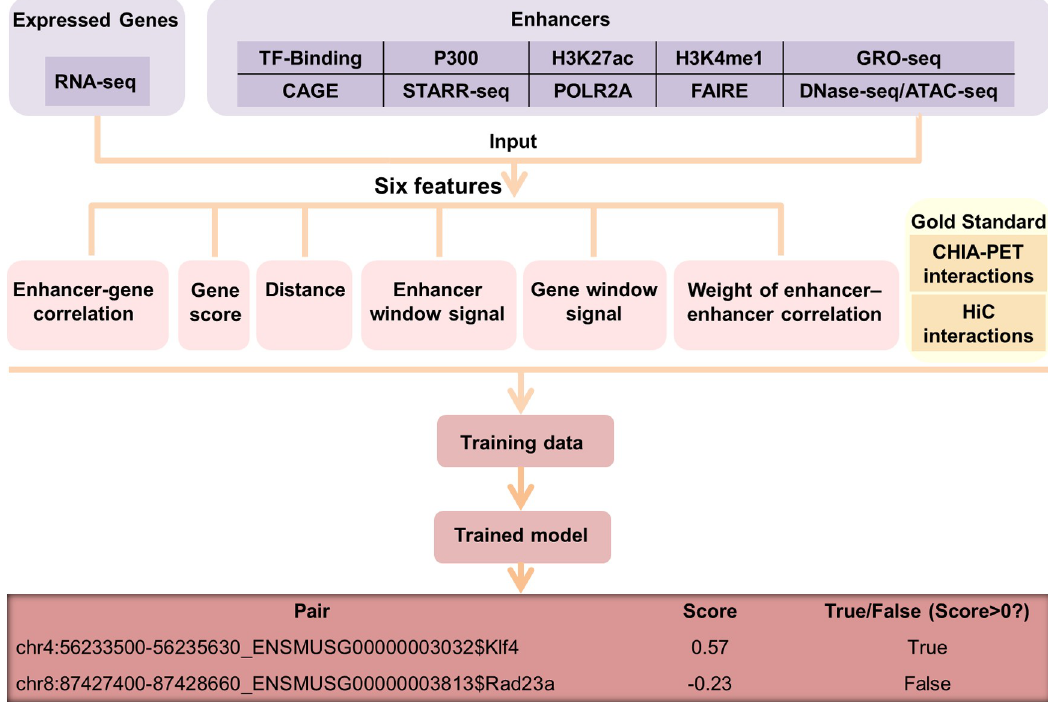
Fig 1. Overview of the EAGLE pipeline. Enhancers were obtained by integrating diverse high-throughput datasets and the expressed levels were estimated using RNA-seq data. We utilized six features based on the information of enhancers and gene expression. ChIA-PET or Hi-C datasets were used to define positive and negative EG pairs. Using the labeled pairs, we trained an ensemble classifier, EAGLE, which could predict enhancer-target interactions measured by prediction probabilities.